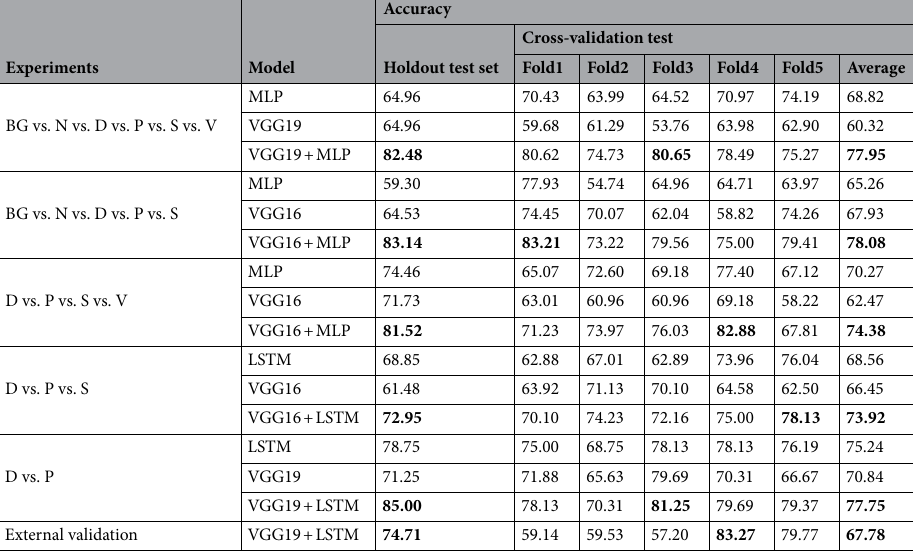
Table 14. Cross-validation on the AZH dataset. The bold represents the highest results/accuracy achieved for each